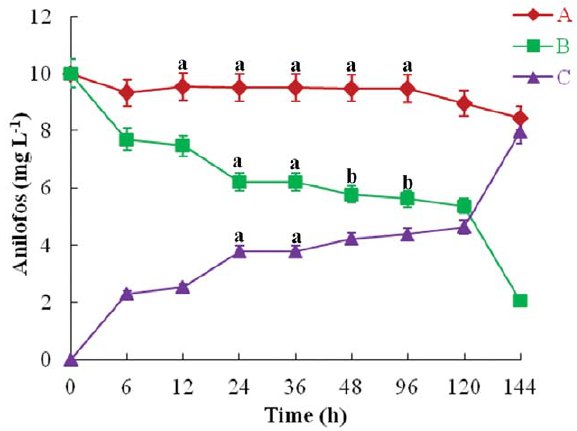
Figure 5. Uptake of anilofos by Synechocystis sp. strain PUPCCC 64. (A) control (without PUPCCC 64 cells); (B) anilofos in medium; (C) anilofos uptake All presented data are the mean values of three independent experiments 6 SD Data at different time intervals with same lower case letters are not significantly different from each other at the 95% confidence level (p ,